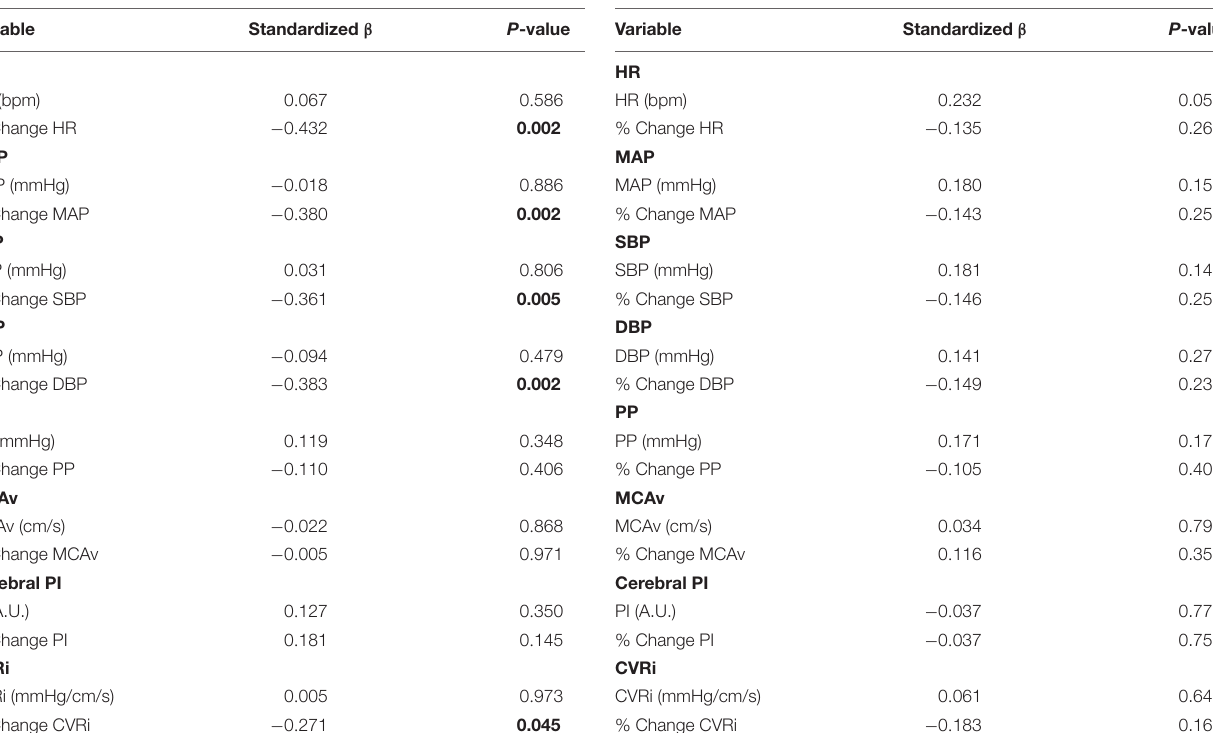
TABLE 5 | Results of multiple linear regression analysis between cardiovascular and cerebrovascular variables during post-exercise ischemia and white matter hyperintensity